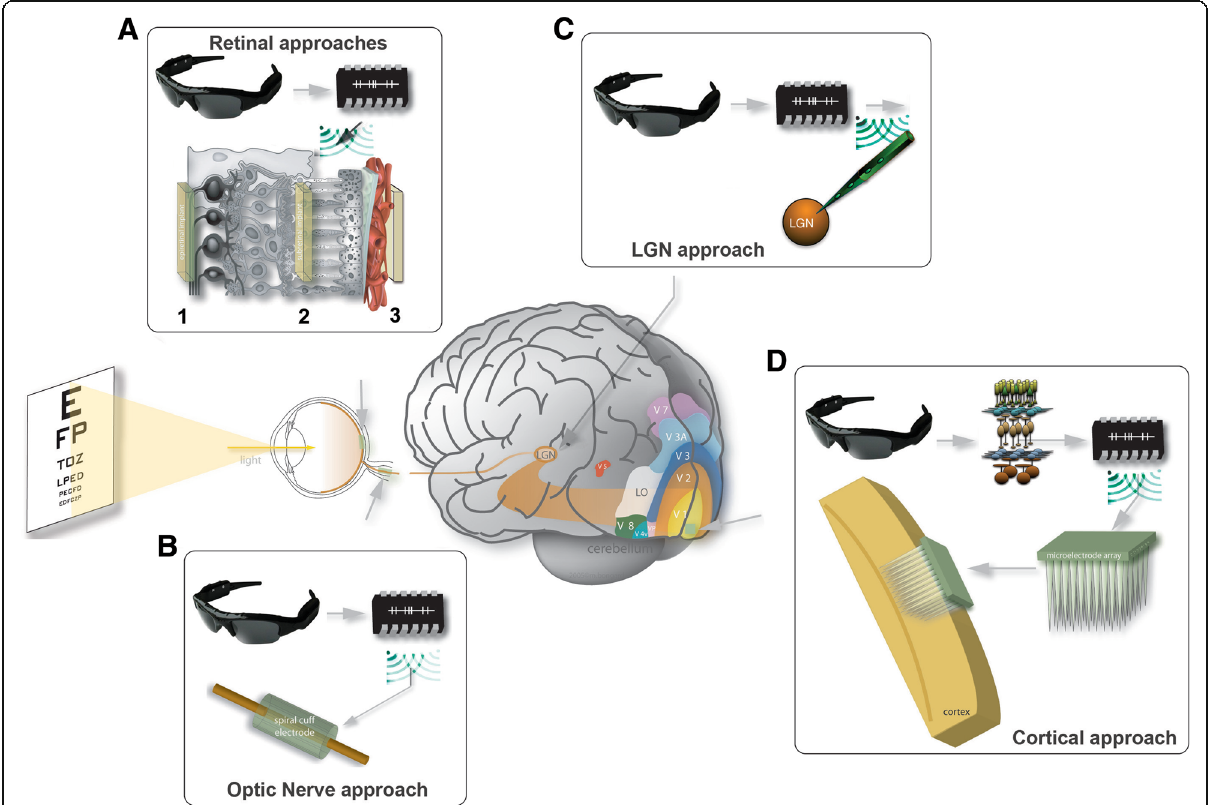
Fig. 2 Main approaches for the design of a visual prosthesis. a Schematic diagram of a retina cross-section showing three methods of stimulating the output cells of the eye: 1, Epiretinal; 2, Subretinal and 3, Suprachoroidal. b Optic nerve based visual prosthesis. c Stimulation of the lateral geniculate nucleus of the thalamus (LGN). d Cortical approach. In general, all the approaches share a common set of components: a camera to capture images, generally mounted on more or less standard glasses; a second stage that transform the visual scene into patterns of electrical stimulation and transmits this information through a radio-frequency link to the implanted device, and an electrode array implanted at some level in the visual pathways which has to be located near the target